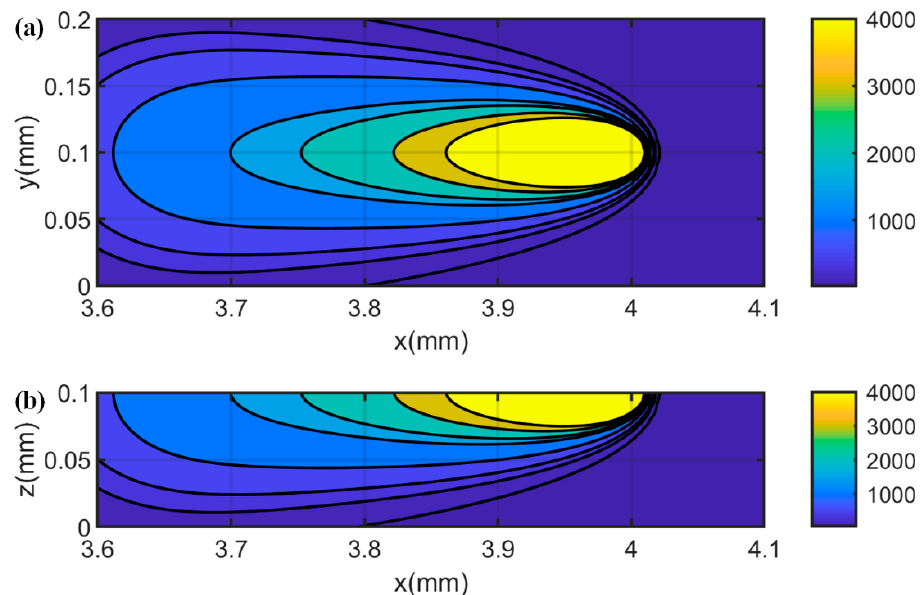
Figure 4. Predicted temperature distribution at t = 5 ms (laser location x = 4 mm, y = 0.1 mm) in single track under test 6 process conditions using 40% absorption. ( a ) Top view; ( b ) cross-sectional view at laser scanning location. It should be noted that the color bar values are corresponding to the temperature contours.